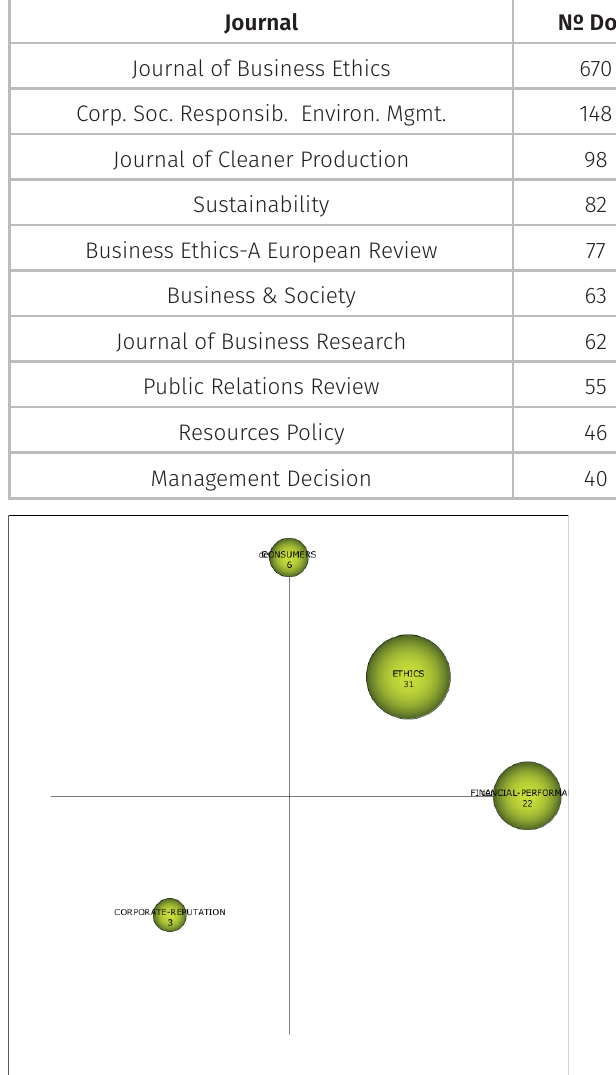
Figure 5. Strategic diagram for the 1978–2006